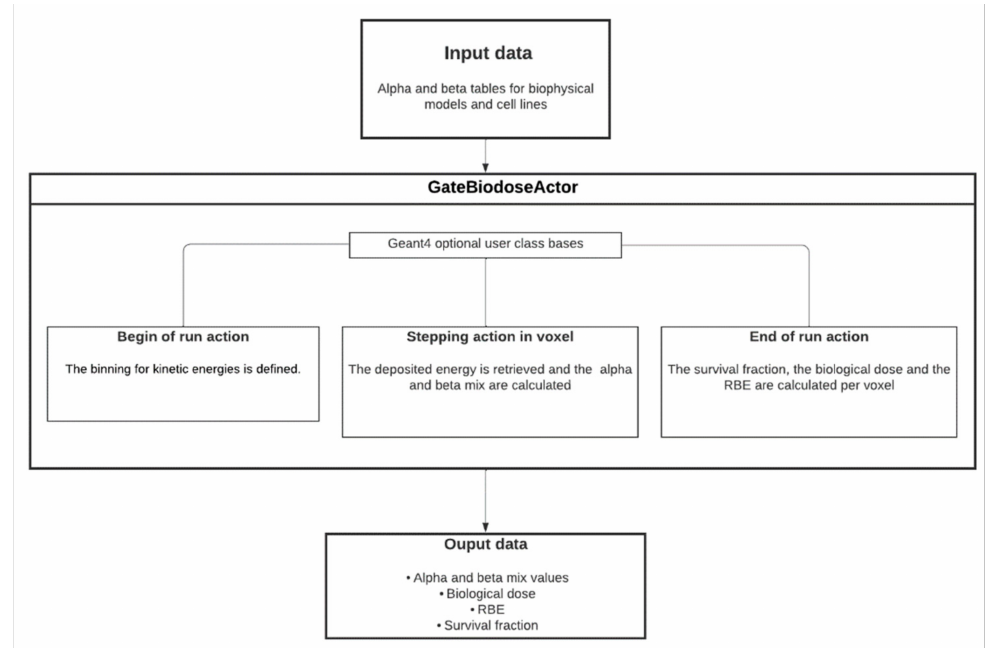
Figure 1. Algorithm of the